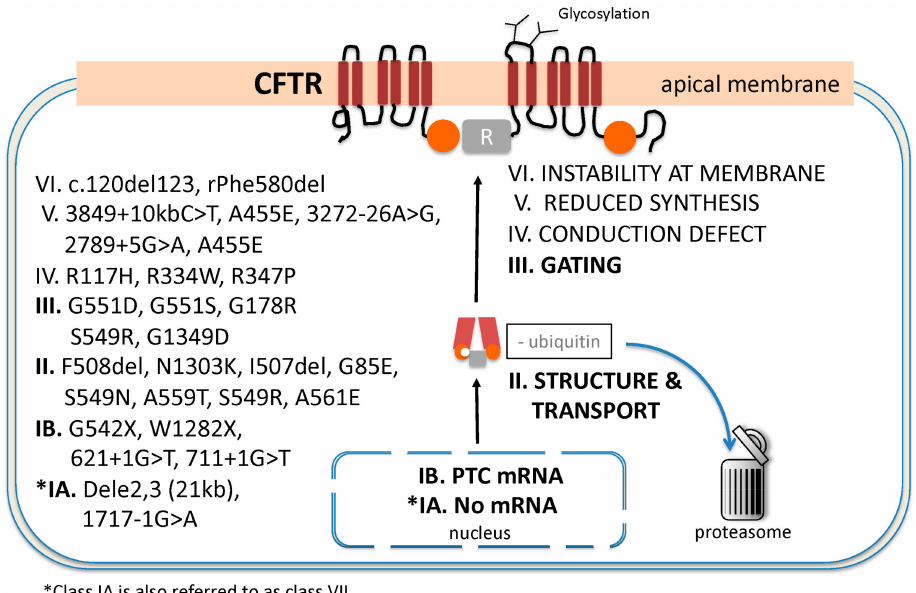
Figure 2. Classification of the CFTR disease-causing mutations. Classes I–III comprise most of the mutations associated with classical CF disease. Examples of alleles of each class are listed for each mutation class. * Class 1A is often referred to as class VII as originally suggested by De Boeck and Amaral